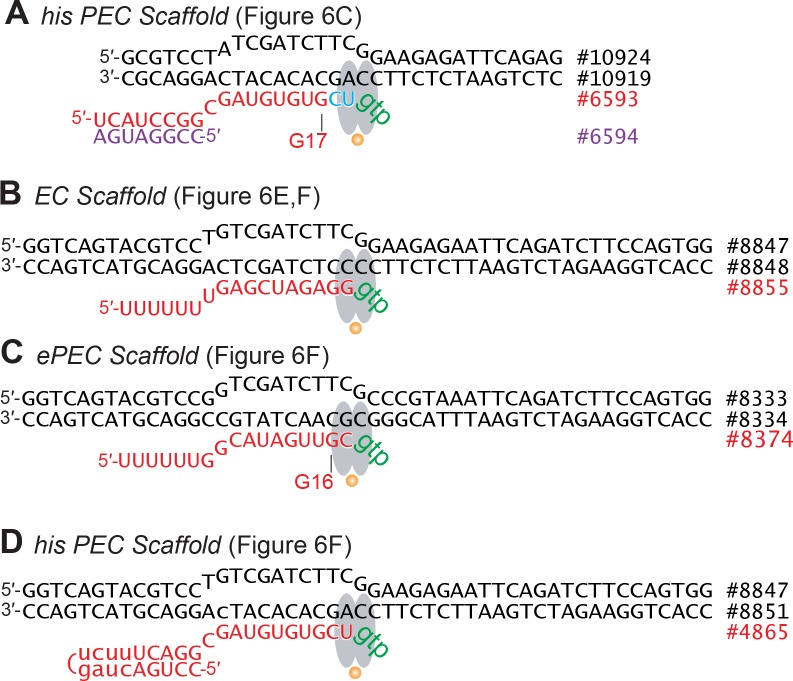
Scaffolds used for CPR and CTR clamp-position assays shown in Figure 6.Full sequences of oligonucleotides are given in Supplementary file 1. (A) Control EC scaffold used in Figure 6E,F (ntDNA#8847, tDNA #8848, RNA #8855). (B) ePEC scaffold used in Figure 6F (ntDNA#8833, tDNA #8834, RNA #8374). (C) hisPEC scaffold used in Figure 6F (ntDNA#8847, tDNA #8851, RNA #4865).